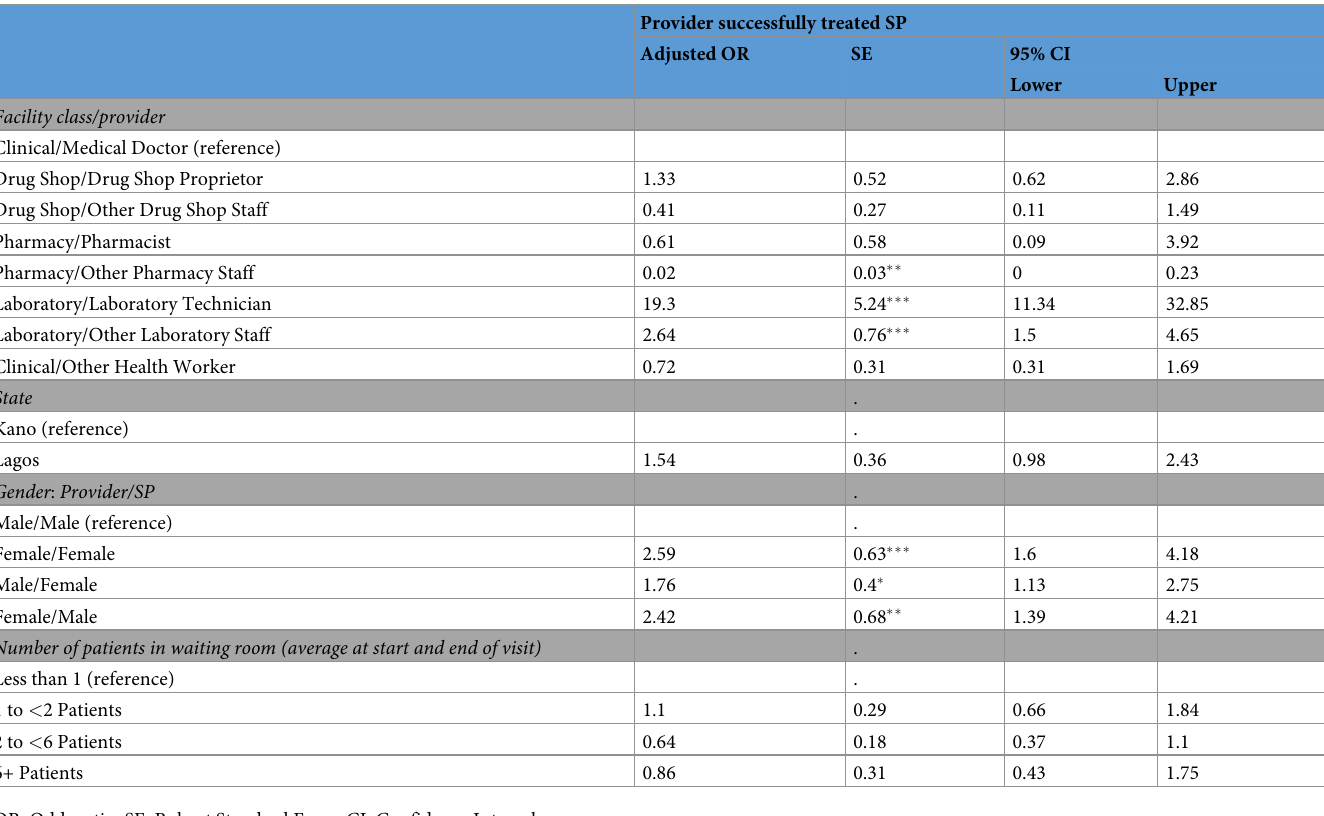
Table 3. Private provider regression results—presumptive patient